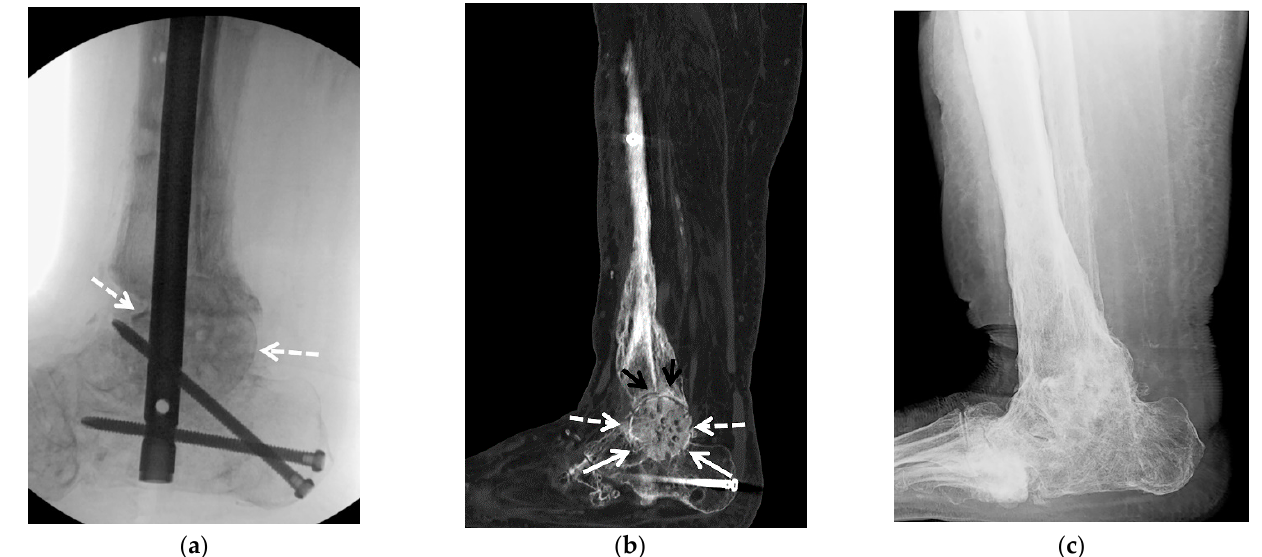
Figure 4. ( a – c ). A 58-year-old male with a complex medical history including diabetes mellitus, infected right Charcot midfoot and hindfoot as well as advanced secondary osteoarthritis, treated with staged fusion: first external fixation with antibiotic spacer and intravenous antibiotics followed by tibiotalocalcaneal fusion with a structural femoral head allograft. ( a ) Fluoroscopic lateral intraoperative image of the right ankle shows a retrograde tibiotalocalcaneal intramedullary nail with two distal screws in the calcaneus and across the posterior calcaneal facet, and a structural femoral head allograft placed at the talar dome bone void and resection site (white arrows). ( b ) Sagittal reformatted CT image obtained 3.5 months after surgery shows the structural femoral head allograft (dashed white arrows) replacing the talar dome, between the calcaneus (white arrows), talar head and tibial plafond (black arrows). Partially visualized is tibiotalocalcaneal fixation hardware. ( c ) Seven months postoperative lateral weight-bearing radiograph status post hardware removal shows complete solid bony fusion across the subtalar and tibiotalar joints with complete incorporation of the structural femoral head allograft.